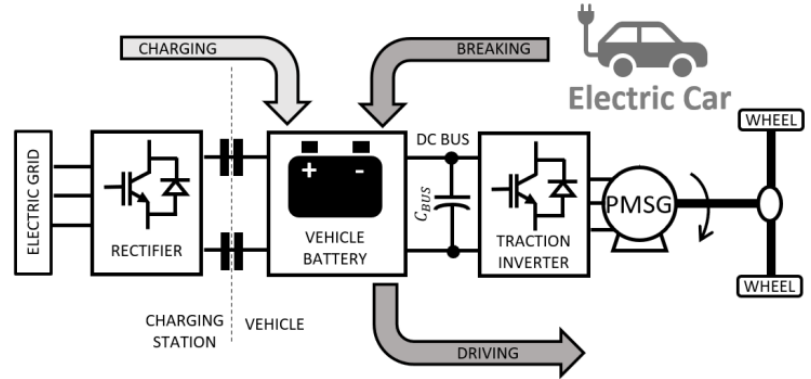
Figure 12. Simplified electrical diagram of the traction drive of EVs.